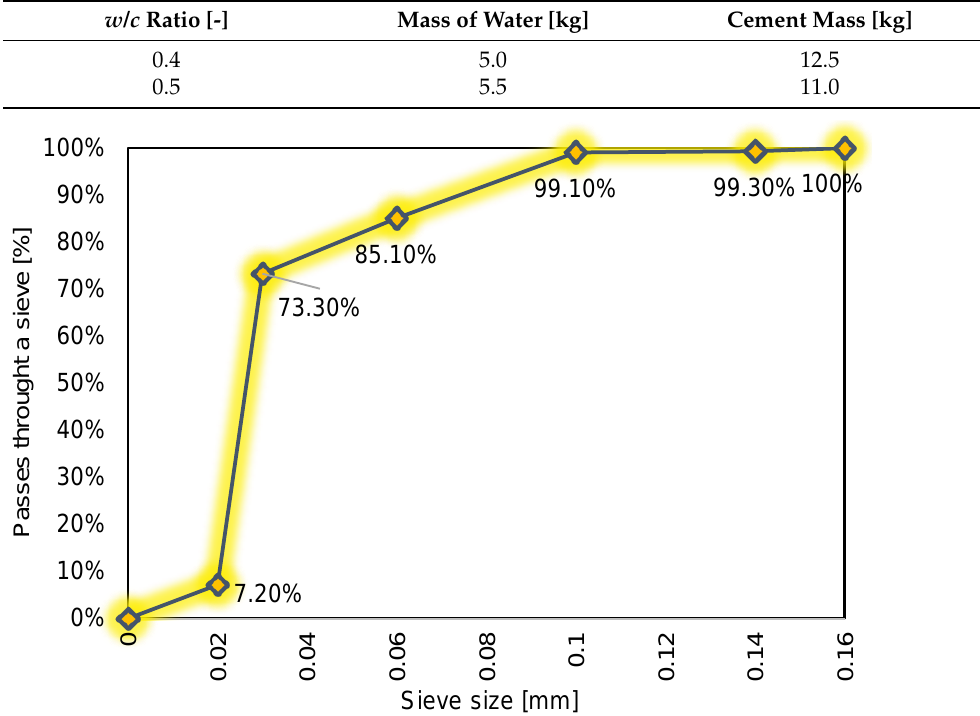
Figure 1. Particle size distribution of cement used to prepare the samples.